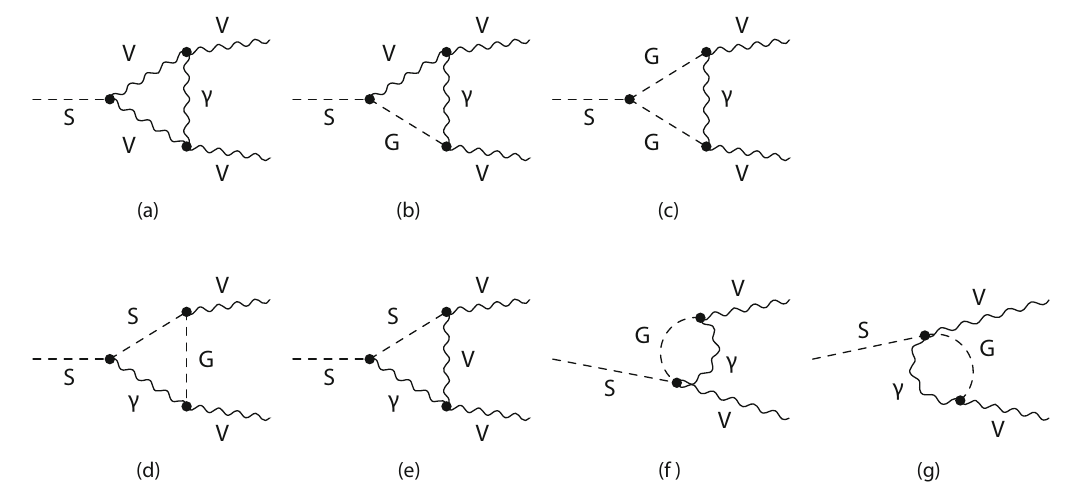
Fig. 23 Diagrams in the decay S → V V (for two heavy vectors) containing a massless gauge boson propagator. Diagrams ( a ), ( b ) and ( c ) must combine in a gauge-invariant way; as do ( d ) and ( e ); diagrams ( f ) and ( g ) are